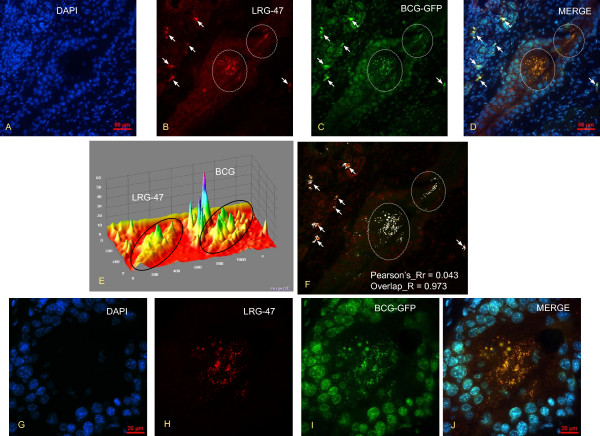
Co-localization of BCG-GFP with LRG47-positive vesicles in the mouse bladder urothelium. Figures 13 A-D are representative photomicrographs obtained 24 hours after bladder instillation of BCG-GFP (1.5 × 107 CFU) into the bladder of anesthetized mice (see material and methods) and Figures 13 G-J are high magnifications of the same area depicted in Figures A-D.  Figures 13 A and 13 G are DAPI [4',6-diamidino-2-phenylindole] that was used to highlight the nucleus. Figures 13B and 13H were stained with LRG-47. Figures 13C and 13I indicate the presence of BCG in the urothelium as indicated by the fluorescence of GFP in two major areas delimited by white circles. Figures 13D and 13J are merged photograph indicating that BCG-GFP is co-localized in vesicles positives for LRG-47 (yellow). White arrows in Figures 13 A-D point to GFP and rhodamine signals that are co-localized in the merge picture (Figure 13D). Next, pictures 13B and 13C were submitted to image analysis by the Interactive 3D Surface Plot [90], a plug-in for ImageJ software [23]. Figure 13E represents the Integrative 3D surface that translates the luminance of the images in Figure 13 B-C as height for the plot using the nearest neighbor sampling. For co-localization of BCG-GFP and LRG47-Rhodamine, pictures were converted to 8-bit gray scale images (fluorescence intensity range: 0 < 255) using Image J software [23] and the analysis was performed with the co-localization-finder plug-in [24]. The results presented in Figure 13F were electronically generated by the software resulting in a merged picture with white areas indicating the co-localization between BCG and LRG-47-positive vesicles and the Pearson's_correlation and overlap coefficient are provided. These results indicate that instillation of BCG-GFP into the mouse bladder, in the conditions described in this manuscript, does not result in urothelial injury and microscopic extravasation of BCG or cause artifacts, including forcing bacteria into the urothelium.